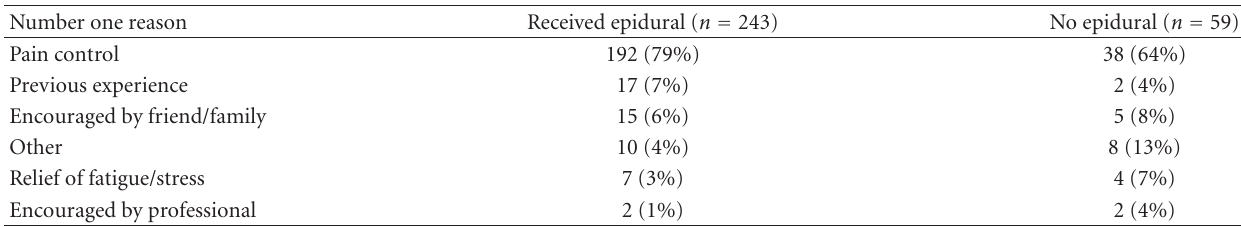
Table 3: Responses to the question. “Before coming to the hospital, what was the number one reason why you might have wanted an epidural for labor?”